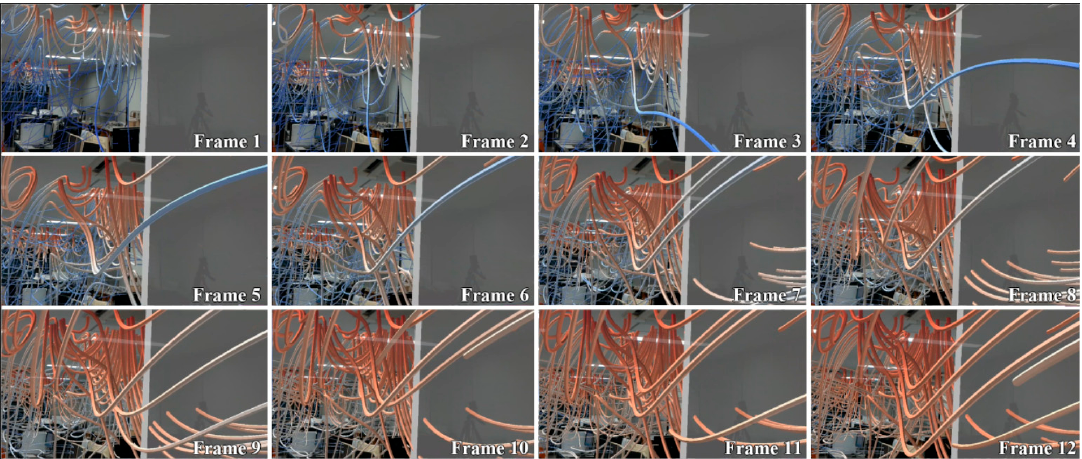
Figure 14. Animated CFD result of case a3 in the HMD.